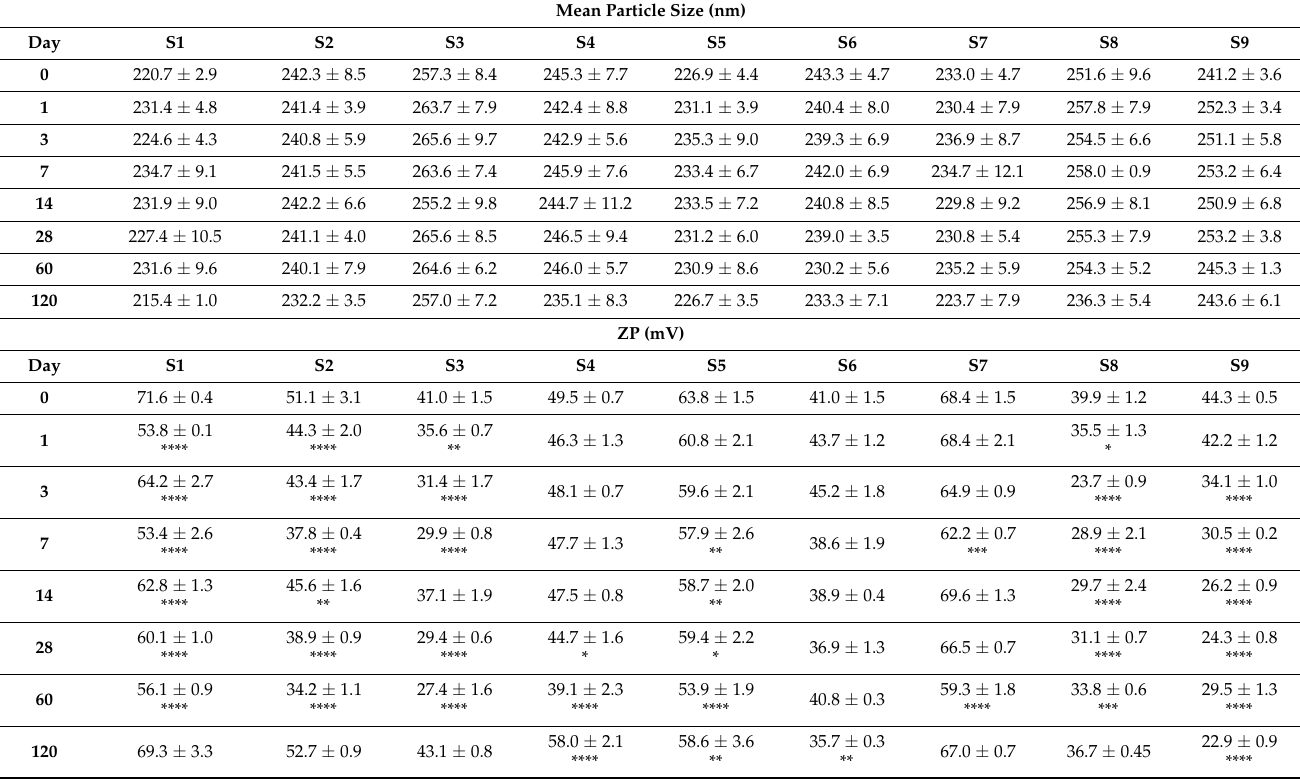
Table 2. Mean size and zeta potential variations of the developed nine nanoemulsions without TA, stored at 4 ◦ C, over a period of 120 days. Results are the mean of three replicates ± standard deviation (S.D.). Statistical significance * p < 0.05; ** p < 0.01; *** p < 0.001; **** p < 0.0001 vs. day